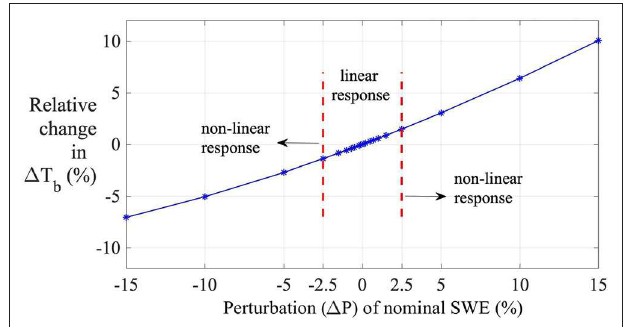
FIGURE 5 | Variability in relative change in SVM-based 1 Tb 18.7–36.5V predictions when modeled SWE (via Noah-MP) is perturbed at a point location in HMA (36.1250 ◦ N, 74.1250 ◦ E) on 03 Jan 2004.